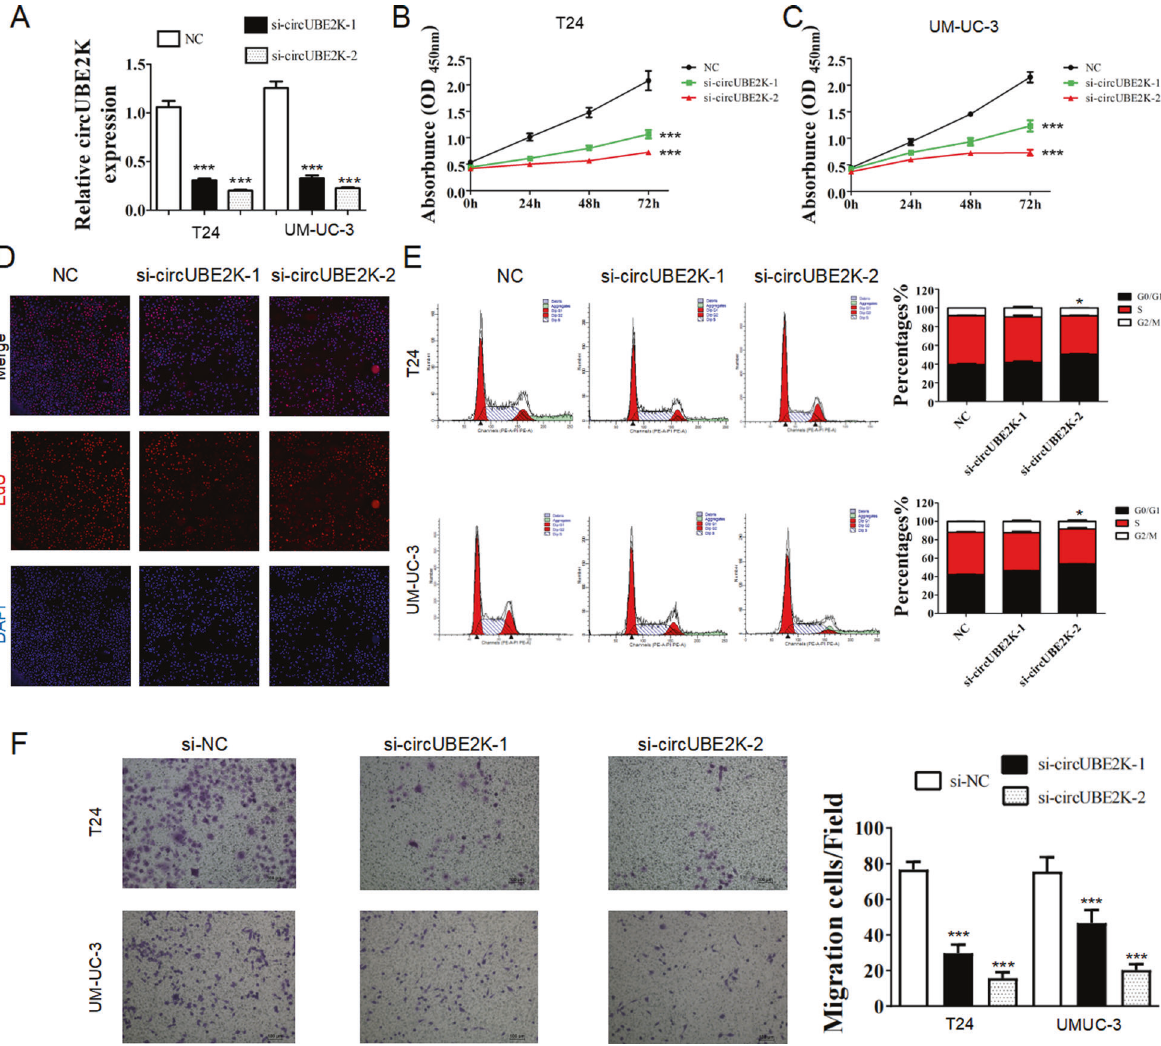
Fig. 2 Knockdown of circUBE2K suppressed BC cell proliferation and migration in vitro. A Transfection of si-circUBE2K signi fi cantly reduced circUBE2K expression in T24 and UM-UC-3 ( *** P < 0.001 vs. NC). Error bars indicate SD. B , C CCK-8 assays showed that transfection of si-circUBE2K signi fi cantly inhibited proliferation of T24 ( B ) and UM-UC-3 ( C ). Error bars indicate SD ( *** P < 0.001 vs. NC). D EdU assay of T24 and si-circUBE2k transfected T24. E Cell cycle distribution of T24 and UM-UC-3 were analyzed by fl ow cytometry. F Transwell assay showed that circUBE2K knockdown hindered migration of T24 and